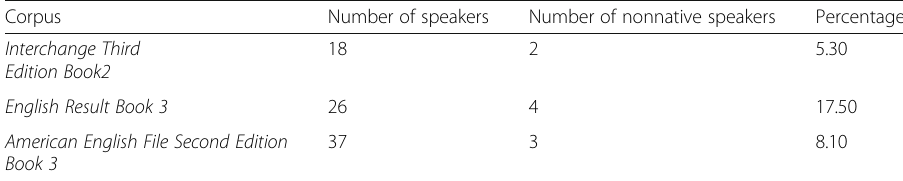
Table 3 Percentage of non-native accents